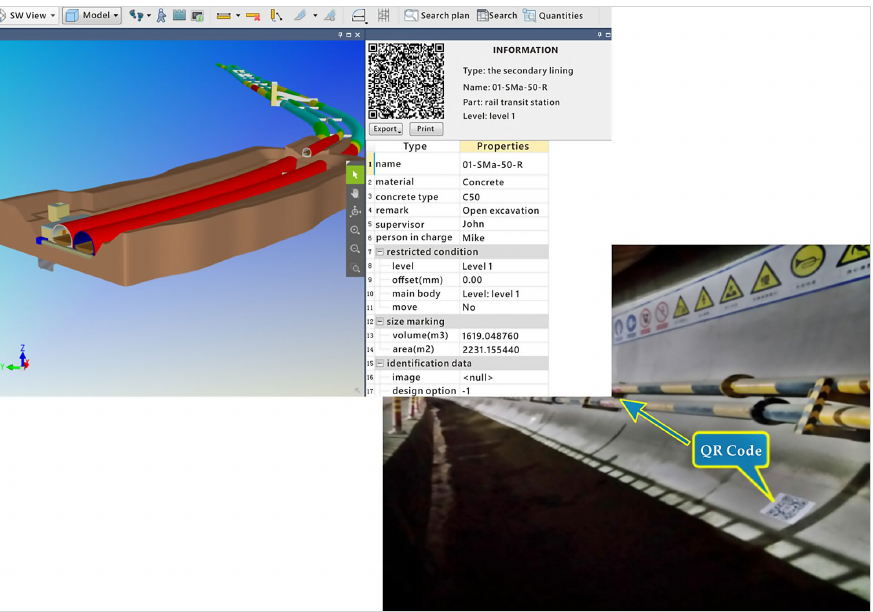
Figure 15. Post a QR code on site containing the construction information for the component